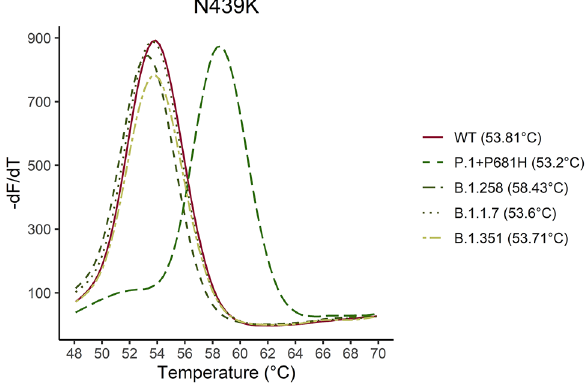
Figure 3. Five samples for the P.1 + P681H, B.1.351, B.1.1.7, B.1.258 and WT were analyzed. The melting curve of the five samples are illustrated for the N439K assay. As it is shown in the graph the N439K mutation can be distinguished by approximately 5 °C from the WT sequence.